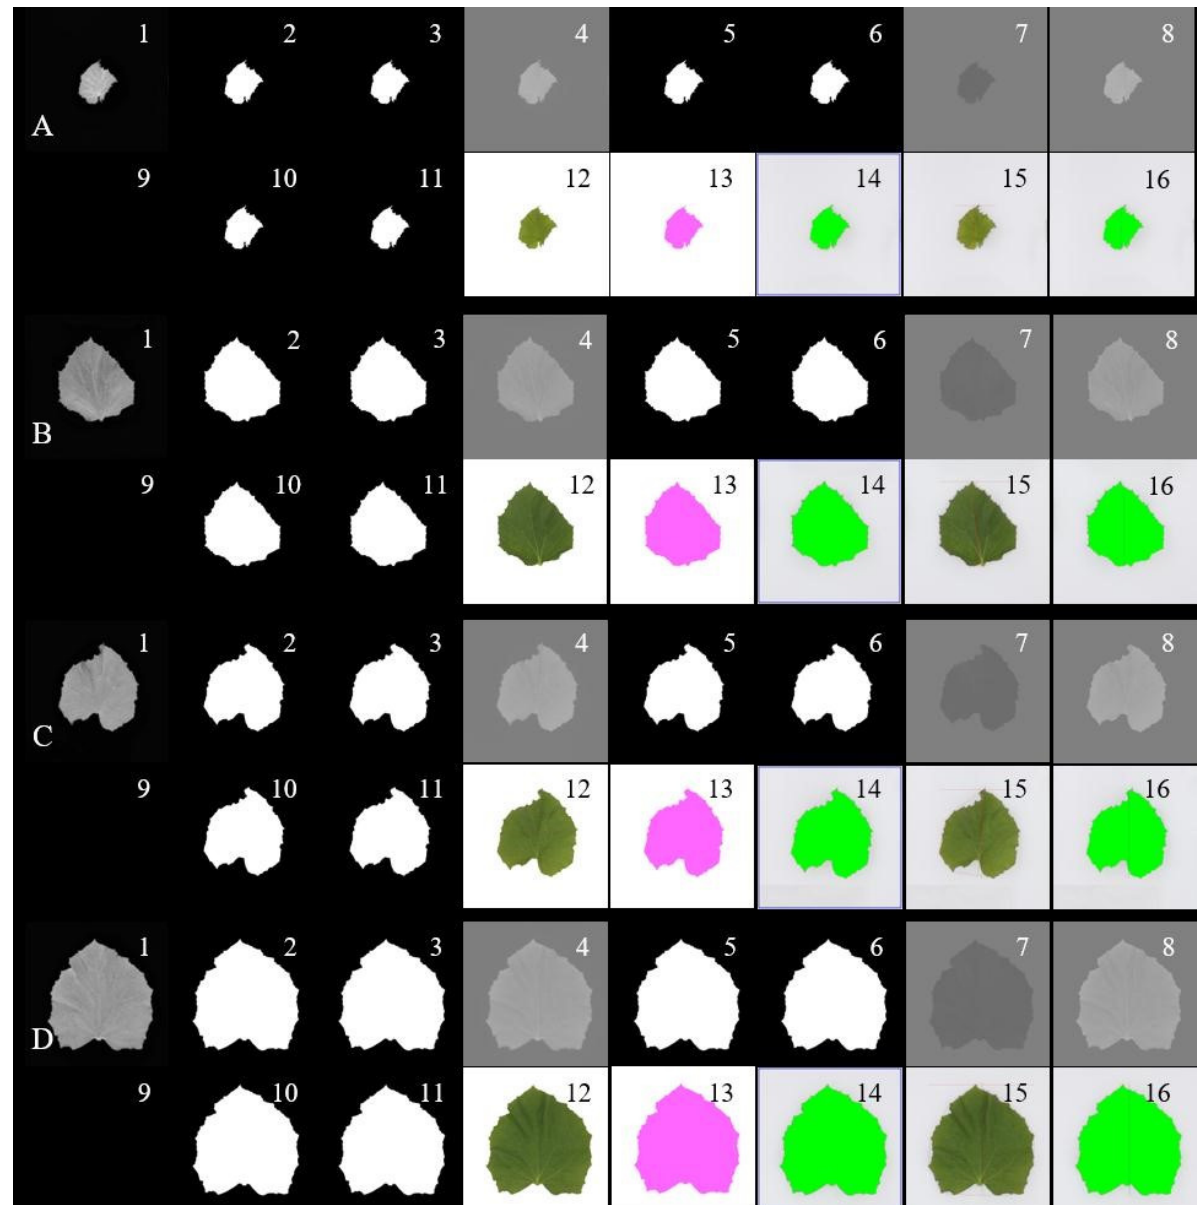
Figure 4. Workflow of leaf image analysis. Note: ( A – D ) 1st–4th fully expanded leaf; 1, to convert the image from RGB to HSV and extract the saturation channel; 2, to threshold the saturation image; 3, “median_blur”; 4, to convert RGB to LAB and extract the blue channel; 5, to threshold the blue image; 6, to join the thresholded saturation and blue-yellow images; 7; to convert RGB to LAB and extract the green-magenta channels; 8, blue-yellow channels; 9, to threshold the green-magenta images; 10, to threshold the blue images; 11, to join the thresholded saturation; 12, to join the blue-yellow images; 13, to decide which objects to be kept; 14, to apply mask; 15, to find shape properties and output shape image; and 16, to shape properties relative to user boundary line.